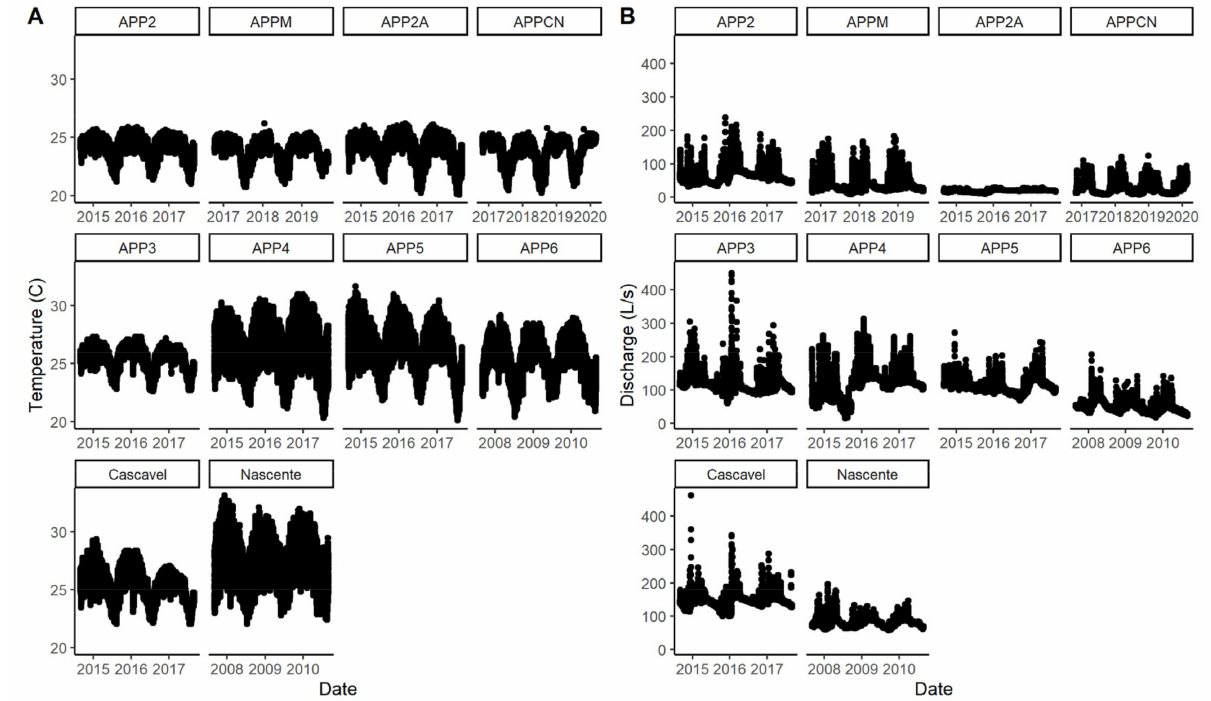
Figure 2. Daily ( A ) stream discharge and ( B ) water temperature in 10 streams included in the